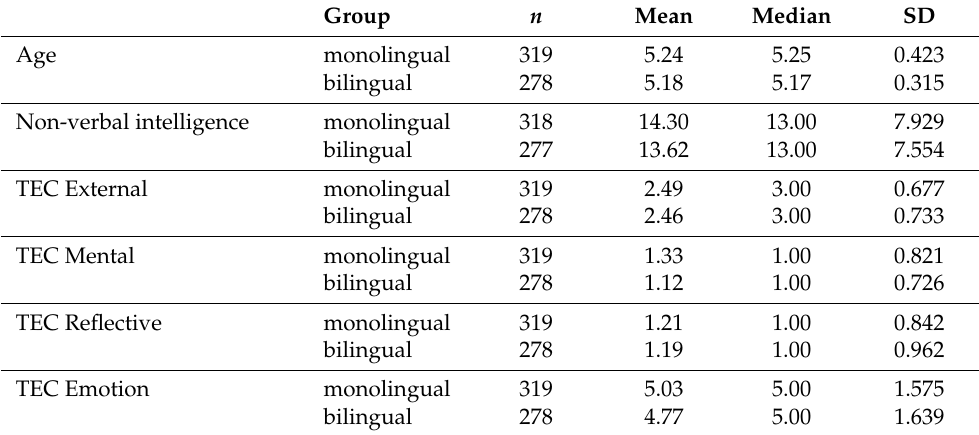
Table 2. Description statistics for study